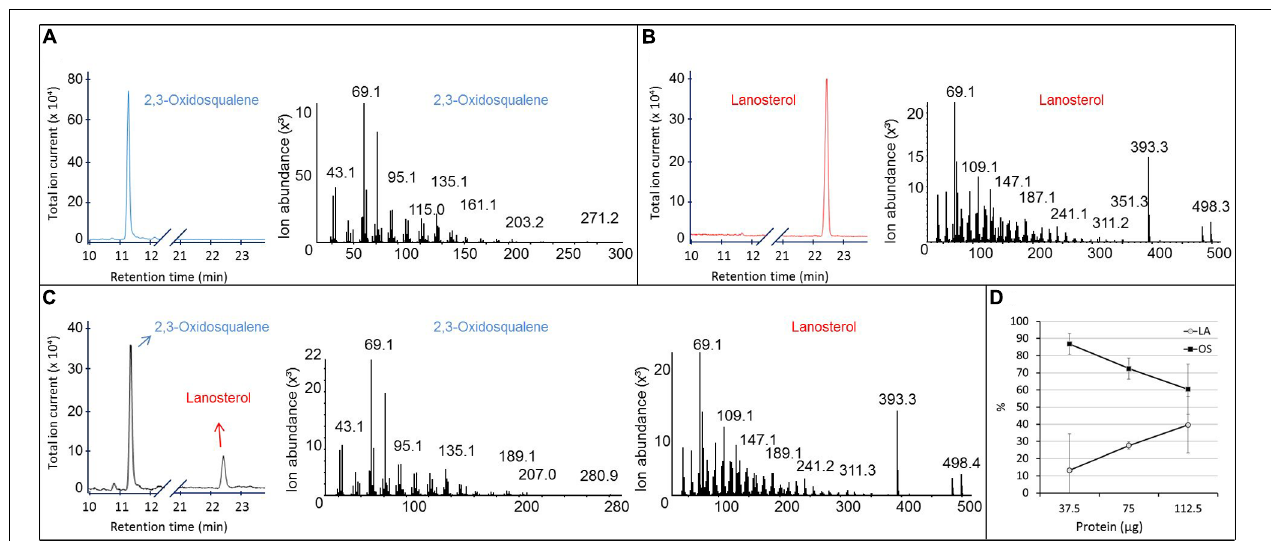
FIGURE 6 | GC-MS analysis of the product formed in vitro by the purified recombinant Sp LASA protein expressed in E. coli . (A,B) Gas chromatogram and corresponding MS fragmentation pattern of OS and LA standards, respectively. (C) GC-MS analysis of the reaction mixture recovered after incubation of 112.5 µ g of the purified recombinant Sp LASA protein with 10.3 µ g OS showing conversion of OS to LA. (D) Incubation of increasing amounts of the purified recombinant Sp LASA with a constant amount of OS (10.3 µ g). The amount of LA formed increased linearly in the presence of increasing amounts of Sp LASA. Reciprocally, the amount of OS recovered at the end of the reaction decreased